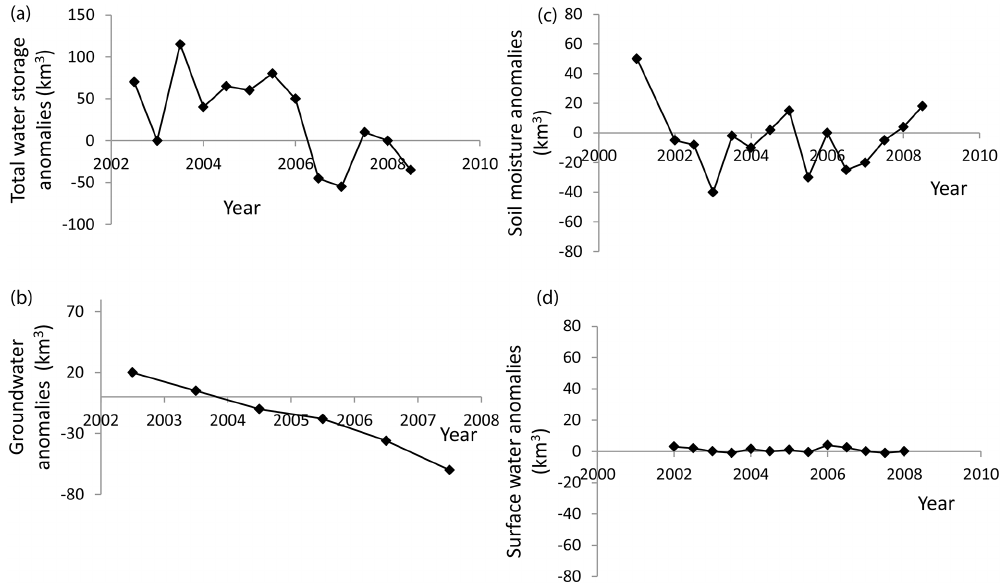
Figure 2. Change in (a) total water storage anomalies; (b) groundwater anomalies; (c) soil moisture storage anomalies; and (d) surface water anomalies relative to the mean of the Murray–Darling Basin during the multiyear drought. Redrawn from Leblanc et al.